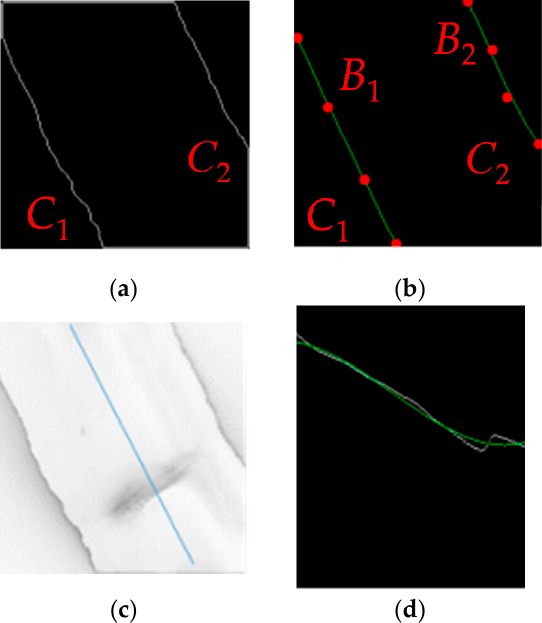
Figure 10. Each stage output of create smooth model processing: ( a ) Contour of I 6 binarization, external contour C 1 , and internal contour C 2 ; ( b ) Bézier curve and control points B 1 converted by C 1 and Bézier curve/control points B 2 converted by C 2 ; ( c ) path p → B 2 ; ( d ) height vector h above p i and regression analysis result of h